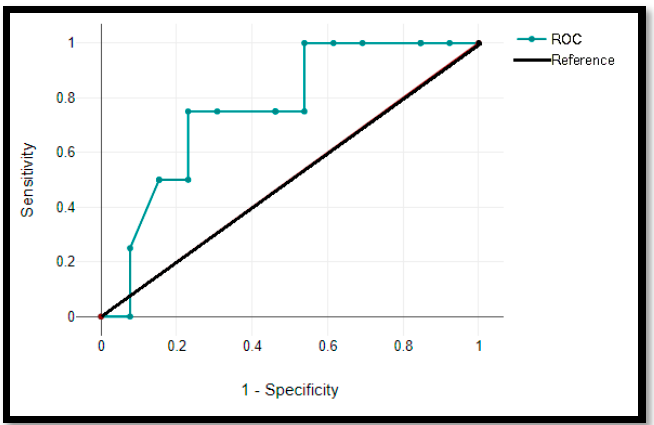
Figure 5. ROC curve.